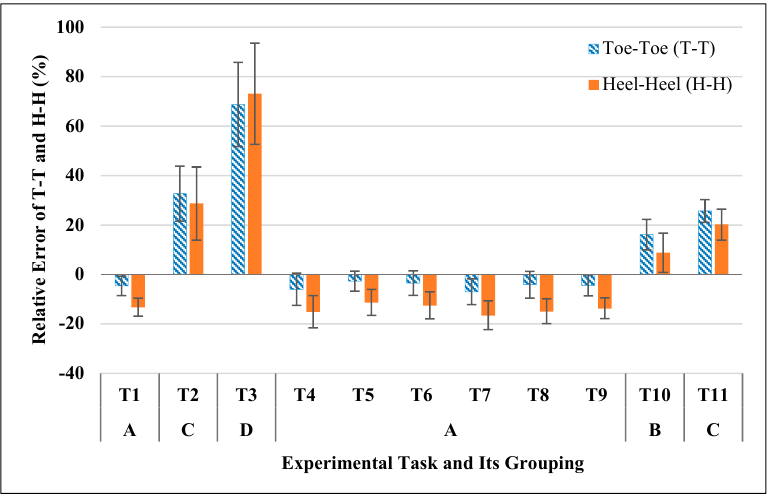
Figure 6. Relative errors of Xsens-based BOS side lengths (Toe-Toe, T-T and Heel-Heel, H-H) in different experimental tasks and post-hoc grouping result (Same letters indicate no significant difference between experimental tasks).